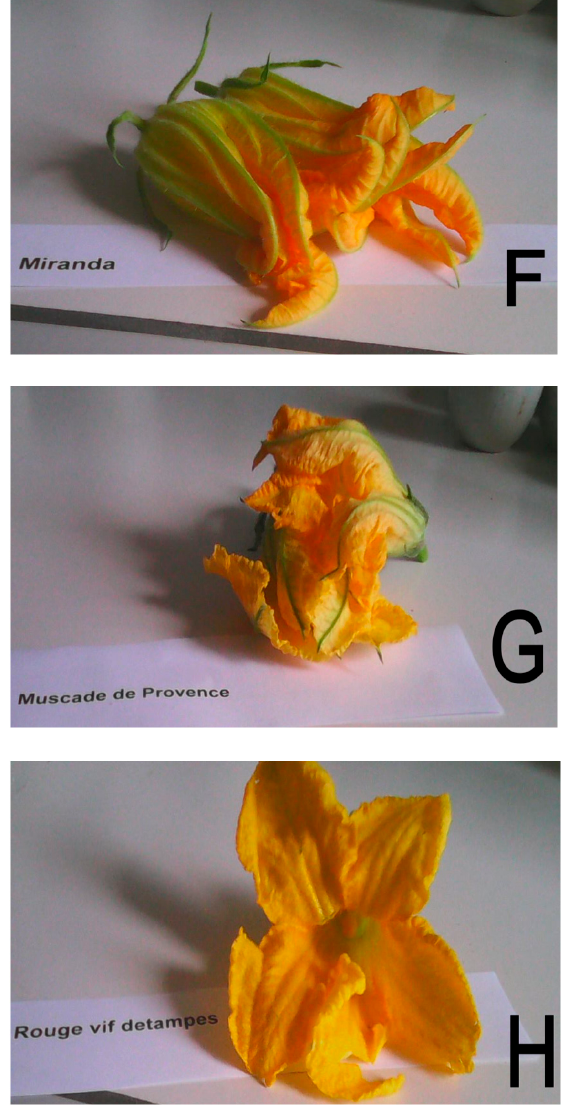
Figure 1. Flowers of various species and varieties of pumpkins: ( A )—Amazonka; ( B )—Ambar; ( C )—Atlantic Giant; ( D )—Bambino; ( E )—Butternut; ( F )—Miranda; ( G )—Muscade de Provance; ( H )—Rouge vif d’Etampes.